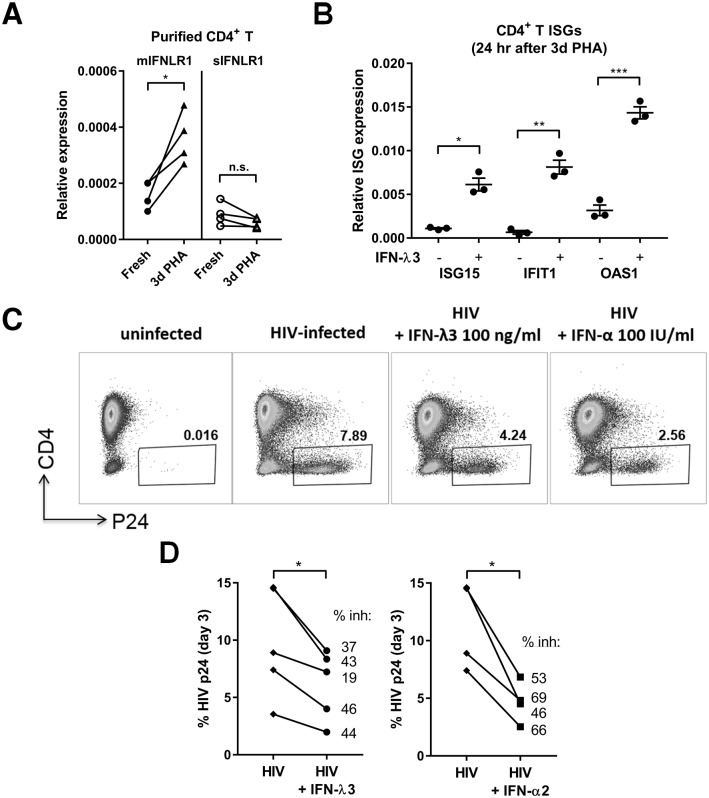
IFN-λ3 inhibits HIV-1 infection of purified CD4+ T cells.A) Relative expression of full length, membrane (mIFNLR1) and small, soluble (sIFNLR1) variant expression in purified CD4+ T cells on day 0 or day 3 after PHA stimulation (normalized to B2M reference gene). B) ISG (ISG15, IFIT1, OAS1) expression in purified CD4+ T cells cultured with or without IFN-λ3 (100 ng/ml) for 24 hrs after 3 days of PHA stimulation. Results are shown as means +/- SD. C-D) Quantification of HIV-1 infection via p24 intracellular flow cytometry. C) Representative p24 staining from 1 healthy individual for all treatments tested. D) % HIV-1 p24 staining from 4–5 different individuals for HIV-1 infection alone compared to cells pre-treated with IFN-λ3 (100 ng/ml) or IFN-α2 (100 IU/ml). Symbols represent means from duplicate wells per individual with each symbol representing a different healthy blood donor. *, P<0.05, **, P<0.01, ***, P<0.001, paired t-tests.